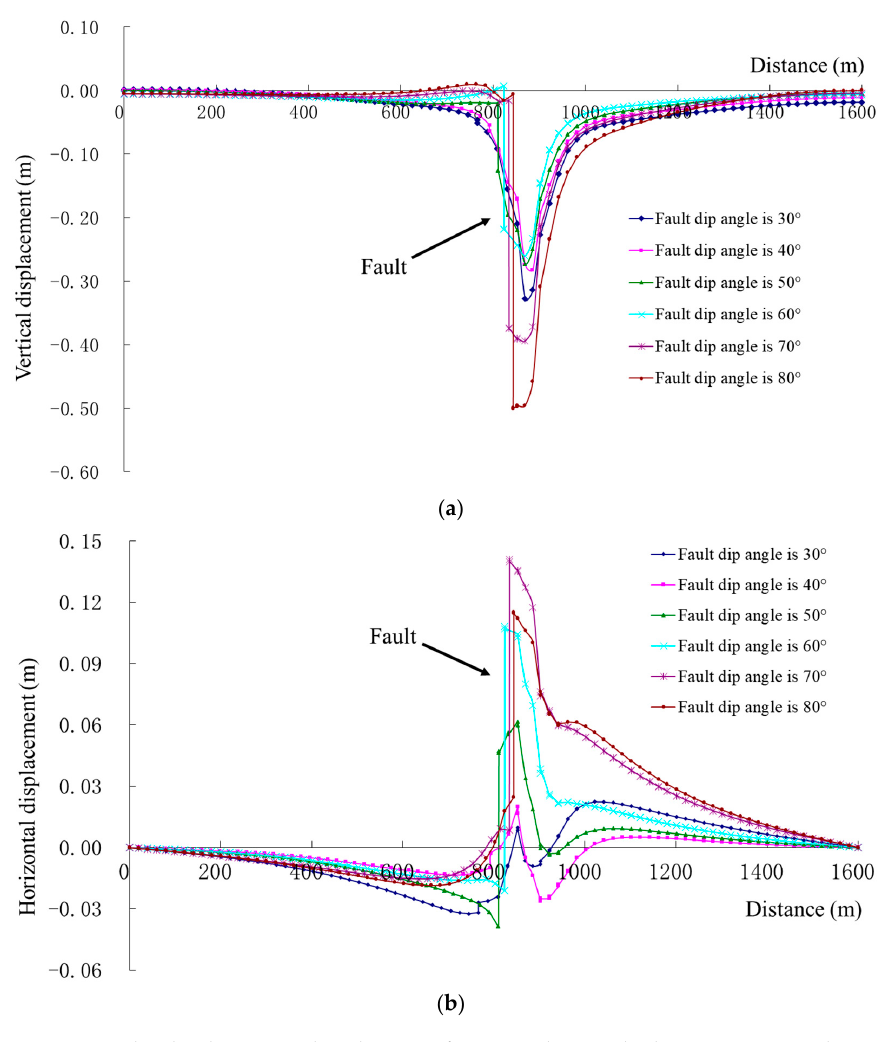
Figure 15. The displacement distribution of surrounding rock along monitoring lines of different fault dip angles, they should be listed as: ( a ) Vertical displacement distribution; ( b ) Horizontal displacement distribution.